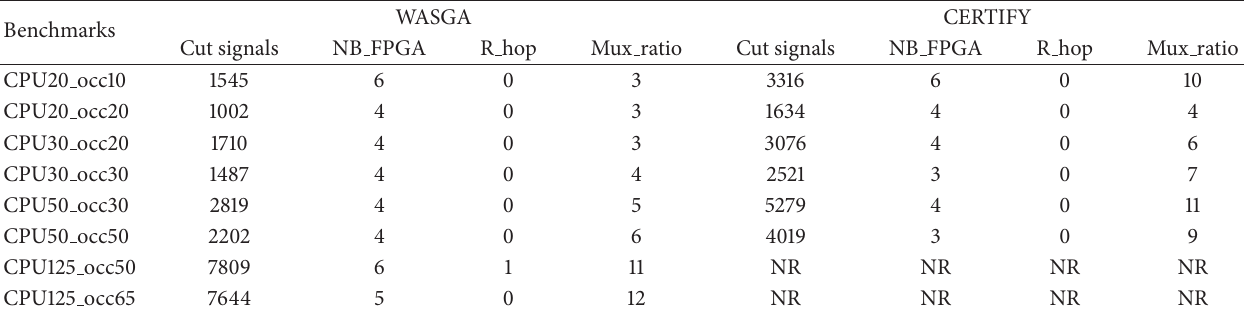
Figure 11: Multiplexing IP architecture. Table 1: Comparison between routing results of WASGA and CERTIFY partitioning